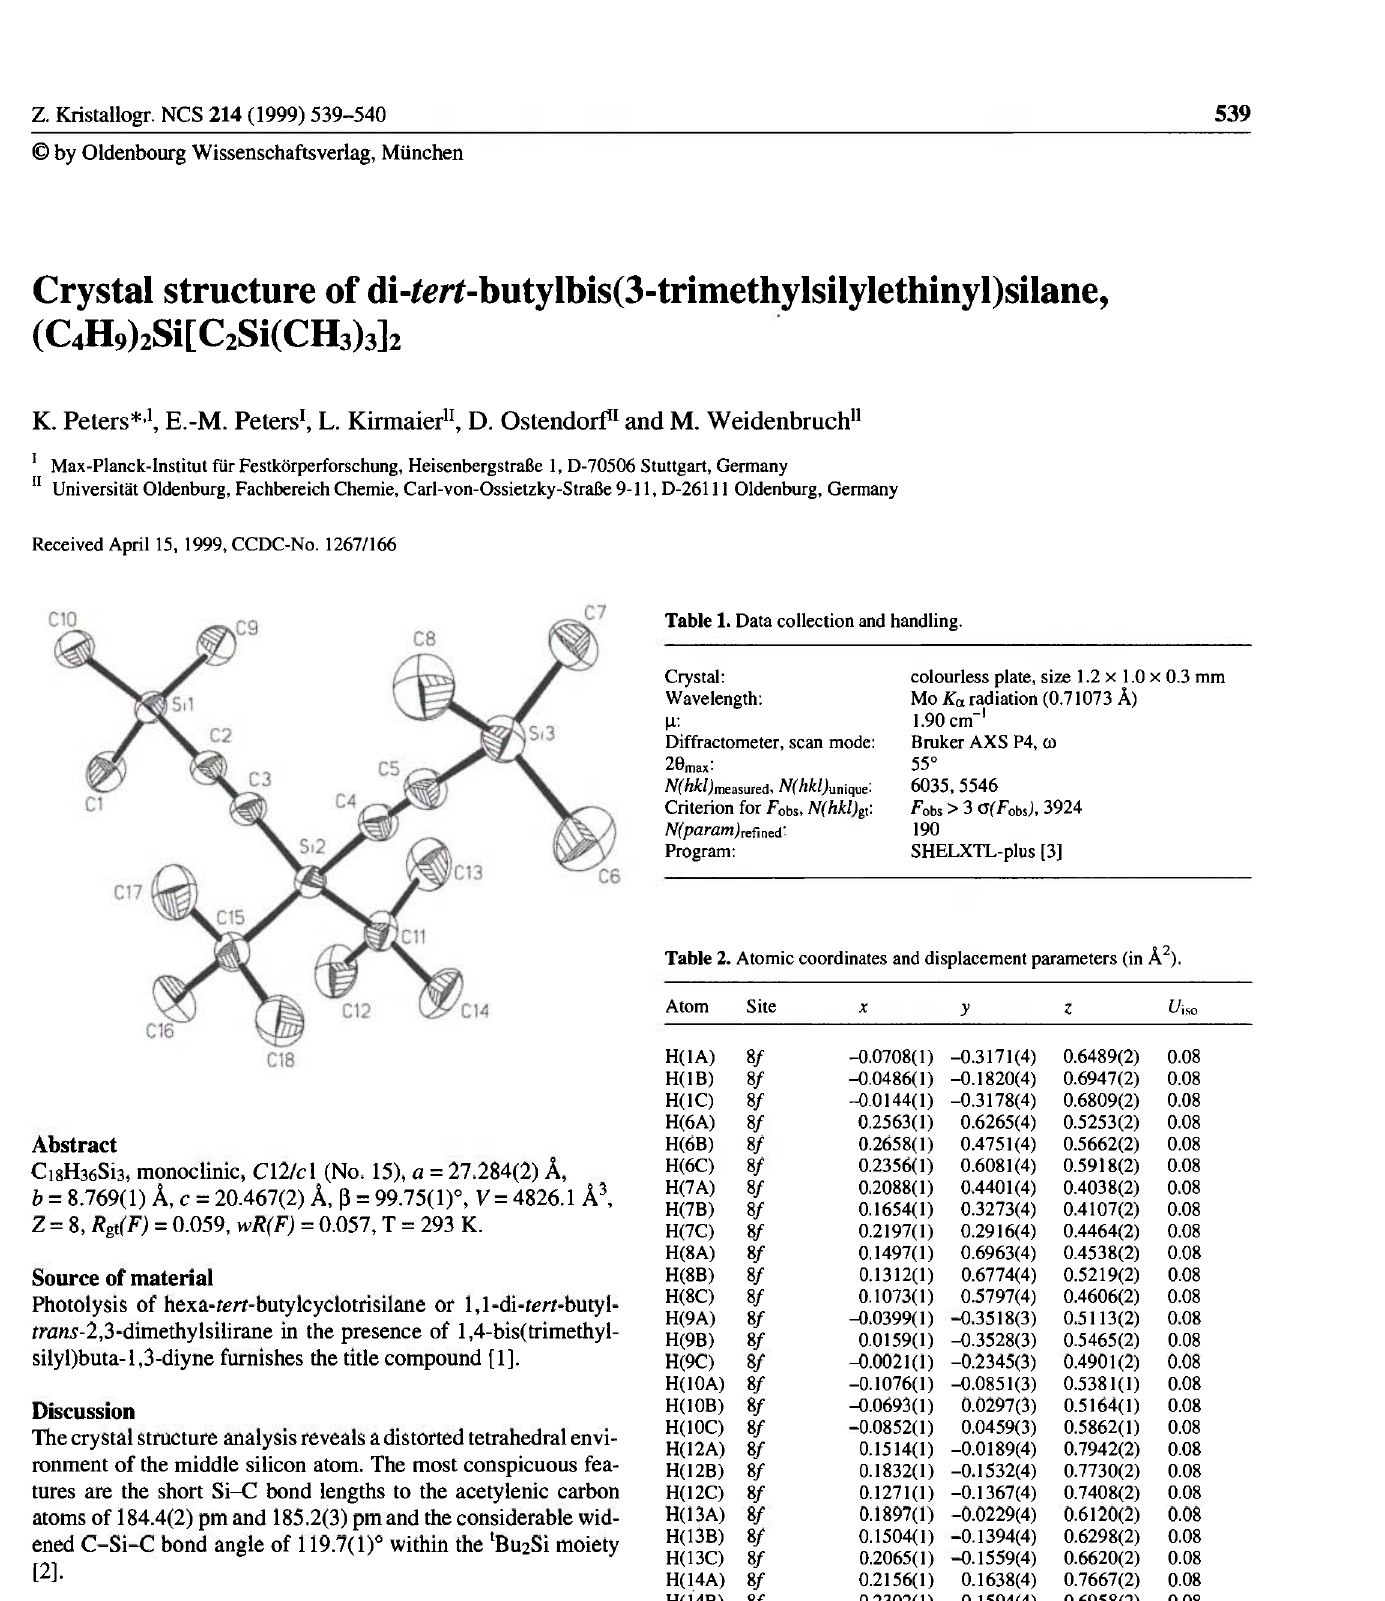
Table 2. Atomic coordinates and displacement parameters (in Ä 2